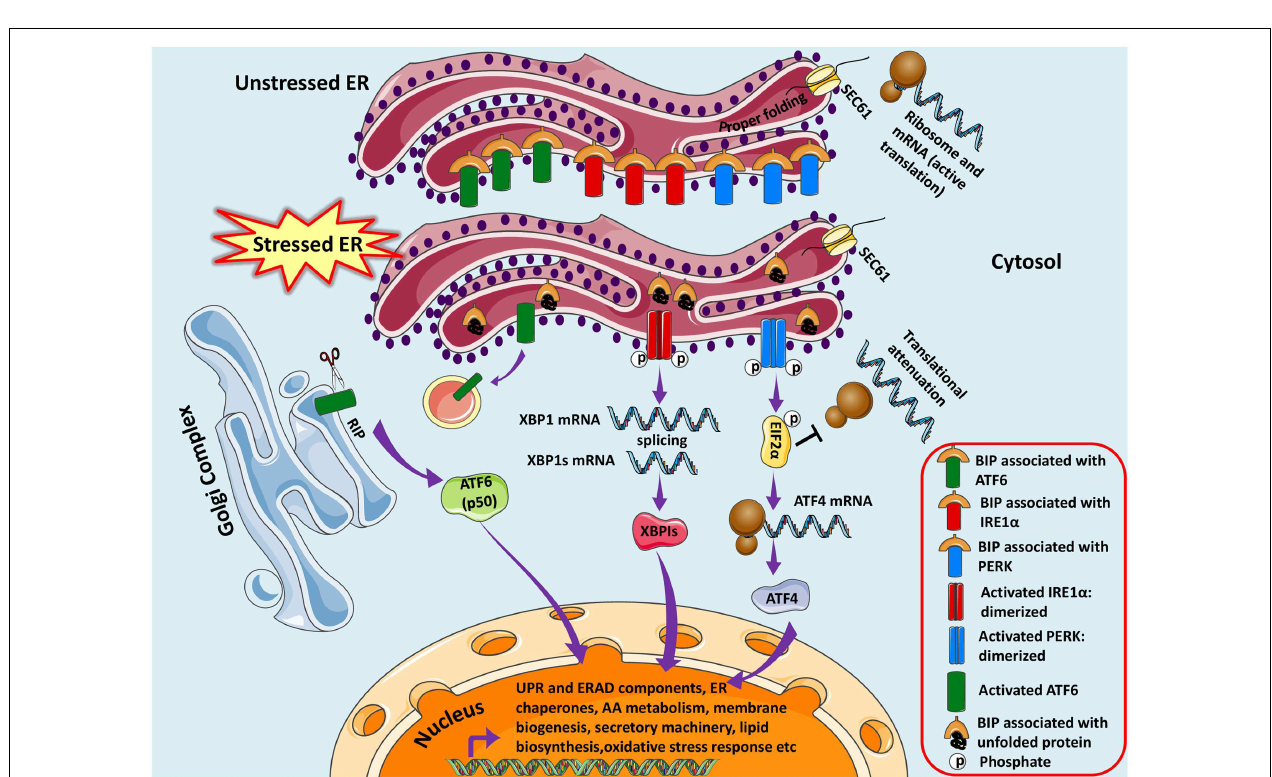
response elements (ERSE) and induces transcription of several genes, including BIP, CHOP (CCAAT/enhancer-binding protein homologous protein), and X-box-binding protein 1 (XBP1). Similarly IRE1 α is activated and undergoes homodimerization and autophosphorylation, thereby activating the endoribonuclease activity, which splices XBP1 mRNA to spliced XBP1 mRNA, which codes for a transcription factor XBP1s that translocates to nucleus and regulates genes involved in UPR and ER-associated degradation (ERAD). Finally, the release of BIP activates PERK pathway, which initiates a global translational arrest by phosphorylating the translation initiation factor 2 α (EIF2 α ), thus decreasing ER protein load. ATF4 (ActivatingTranscription Factor 4) mRNA escapes translational suppression exclusively as it possesses internal ribosome entry site (IRES) sequences in the 5 (cid:48) -untranslated regions. ATF4 enters nucleus and regulates expression of UPR target